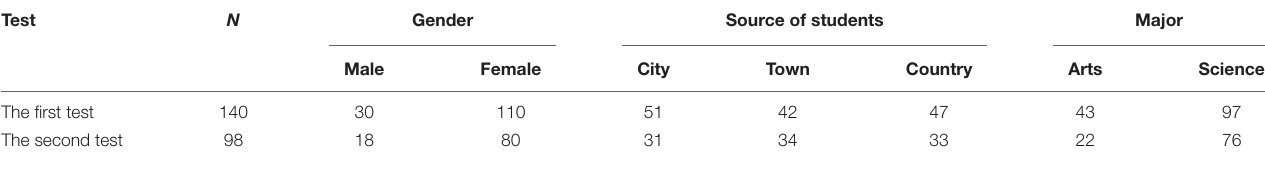
TABLE 1 | Participants’ demographic